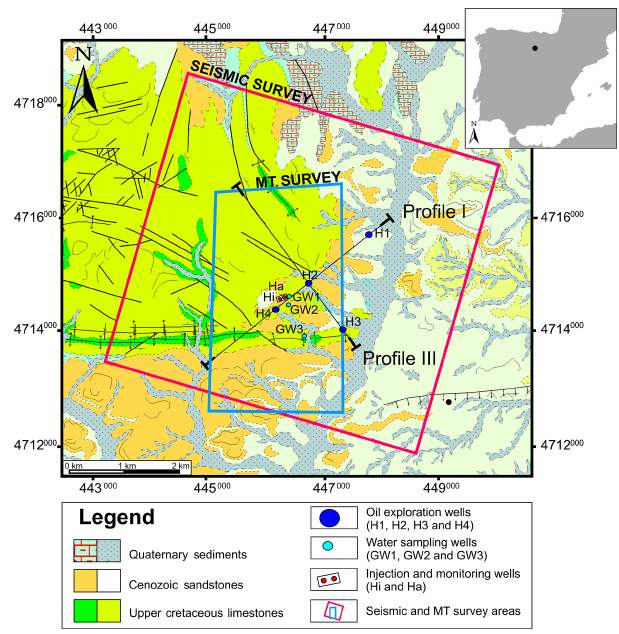
Figure 1. Location of the study area, MT survey, seismic survey, and wells. Profiles I and III refer to the position of the cross-sections shown in Fig.